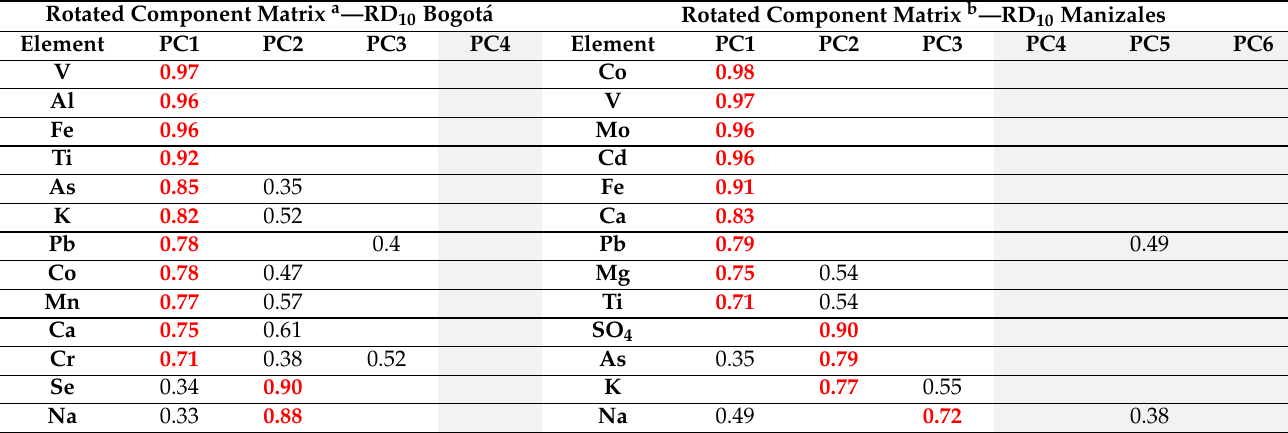
Table 3. Rotated component of PCA for road dust in Bogot á (n = 20) and Manizales (n = 14). Only significant values (>0.32) are presented. Highest values (>0.7) are shown in red. Rotated Component Matrix a —RD 10 Bogot